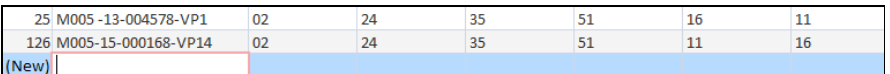
Figure 4. A screenshot of the “VP database”, after the application of filters based on the HLA of the patient #12345 of Table 4.